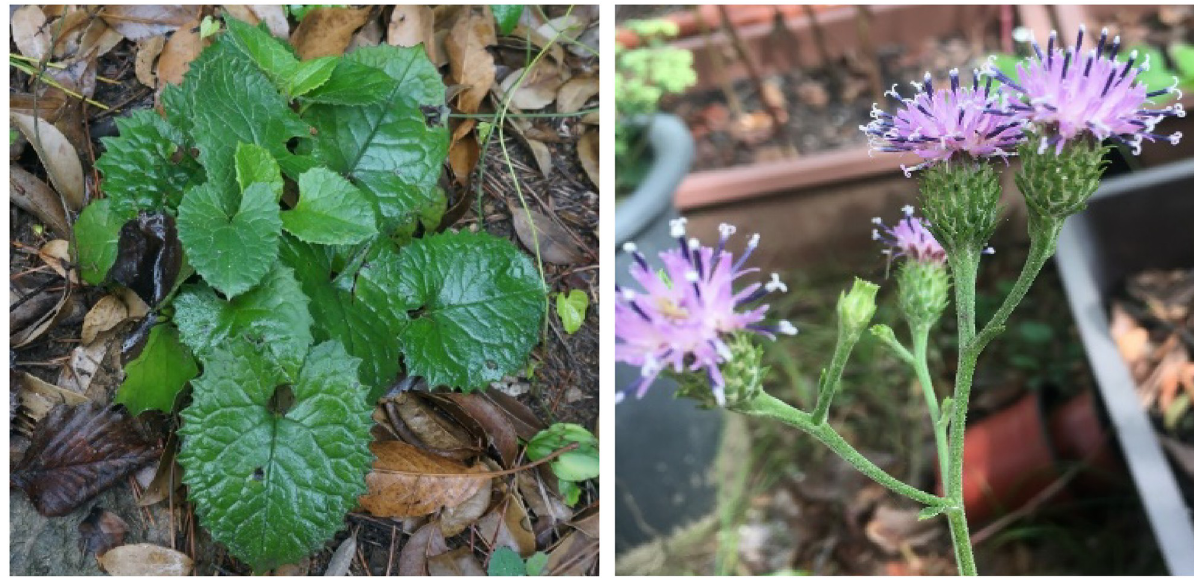
Fig 1. Photographs of Saussurea polylepis in Heuksando. Found only on 6 southwestern continental islands of Korea and mainly observed around hiking trails. Climate change, anthropogenic activities, and herbivores are the main threats to population decline.